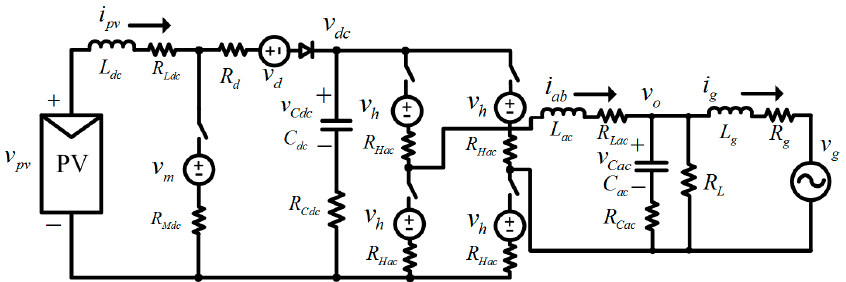
Figure 5. Circuit model for deriving the average model.